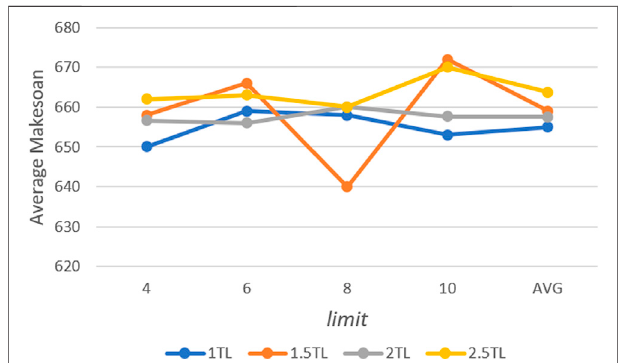
FIGURE 5 | Trend of average solution with Ps and limit .